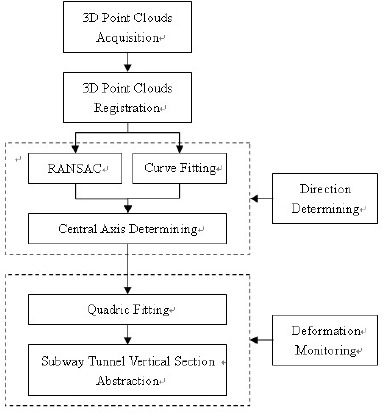
Fig.1 The flowchart of the proposed algorithm